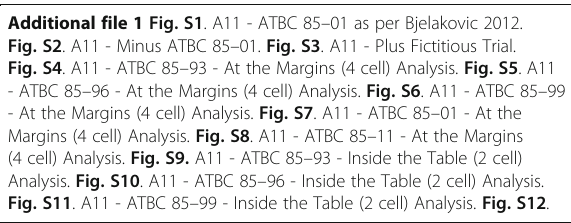
Fig. S4 . A11 - ATBC 85 – 93 - At the Margins (4 cell) Analysis. Fig. S5 . A11 - ATBC 85 – 96 - At the Margins (4 cell) Analysis. Fig. S6 . A11 - ATBC 85 – 99 - At the Margins (4 cell) Analysis. Fig. S7 . A11 - ATBC 85 – 01 - At the Margins (4 cell) Analysis. Fig. S8 . A11 - ATBC 85 – 11 - At the Margins (4 cell) Analysis. Fig. S9. A11 - ATBC 85 – 93 - Inside the Table (2 cell) Analysis. Fig. S10 . A11 - ATBC 85 – 96 - Inside the Table (2 cell) Analysis. Fig. S11 . A11 - ATBC 85 – 99 - Inside the Table (2 cell) Analysis. Fig. S12